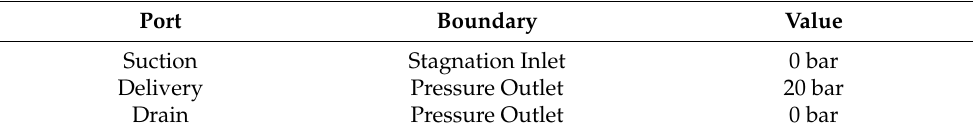
Figure 7. Suction and delivery ports of the EGP model. Table 3. Boundary conditions.